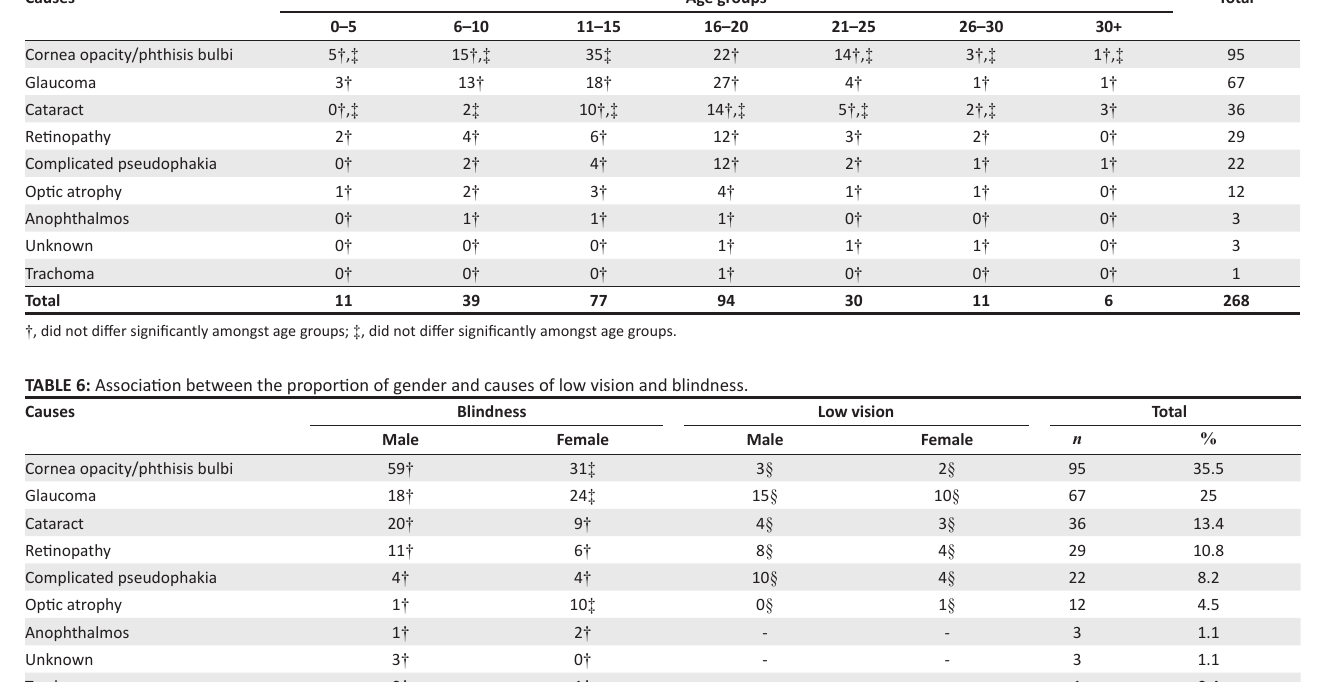
TABLE 5: Causes of low vision and blindness in the better eye according to age group.